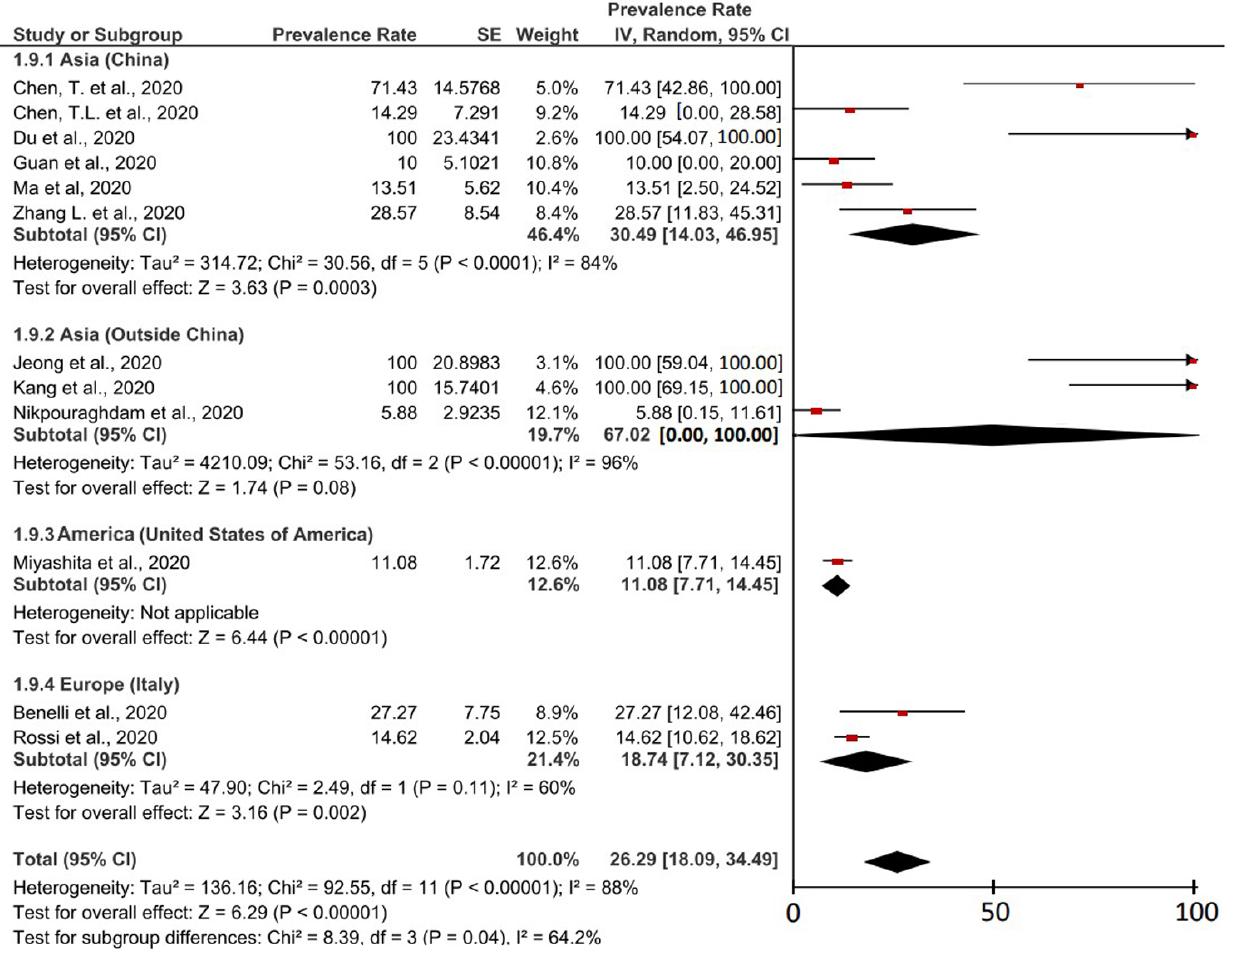
therapy.Figure 4. Forest plot of case-fatality rates of COVID-19 patients with cancer as a